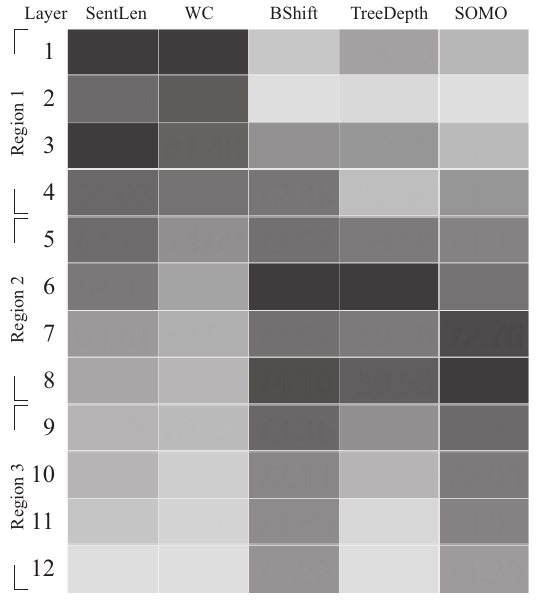
Figure 3. Heat map of probing task